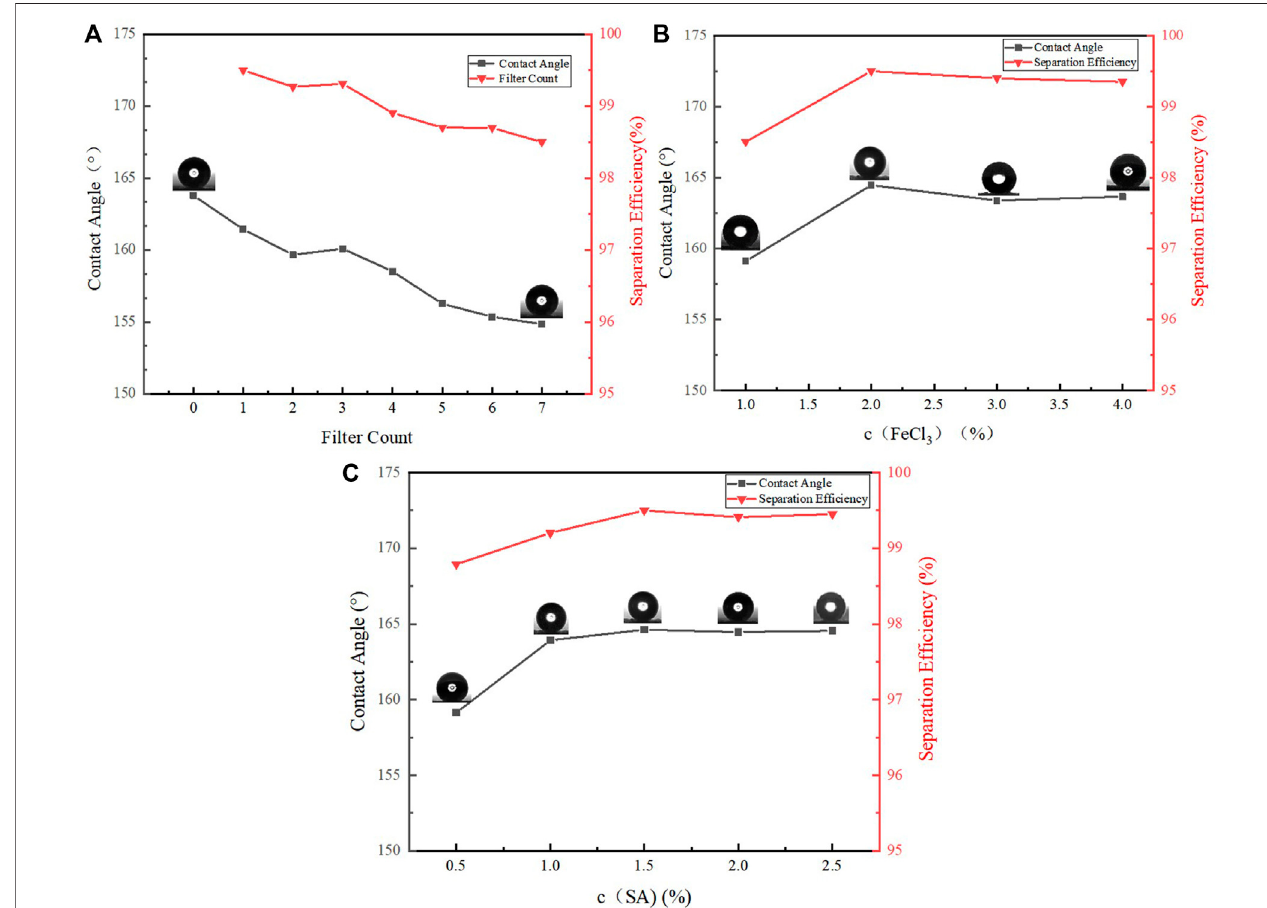
FIGURE 10 | (A) Variation of oil-water separation ef fi ciency and WCA with fi lter count, (B) Variation of oil-water separation ef fi ciency and WCA with FeCl 3 concentration, (C) Variation of oil-water separation ef fi ciency and WCA with SA concentration.